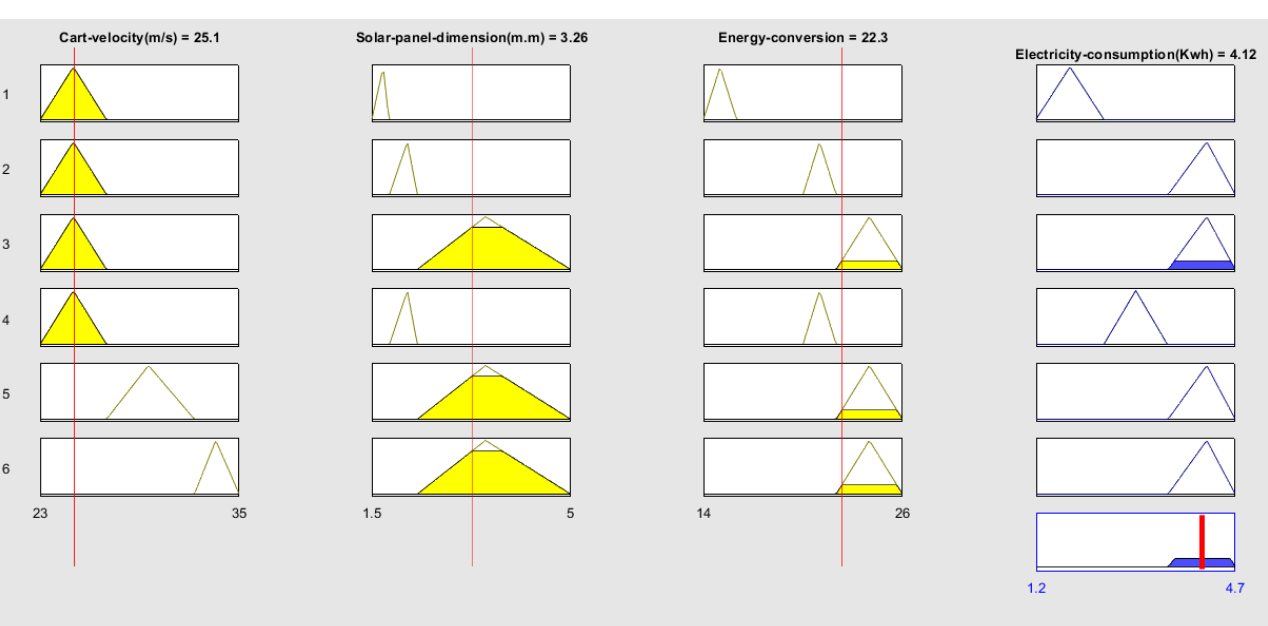
Table 6. Output results from the proposed fuzzy system.